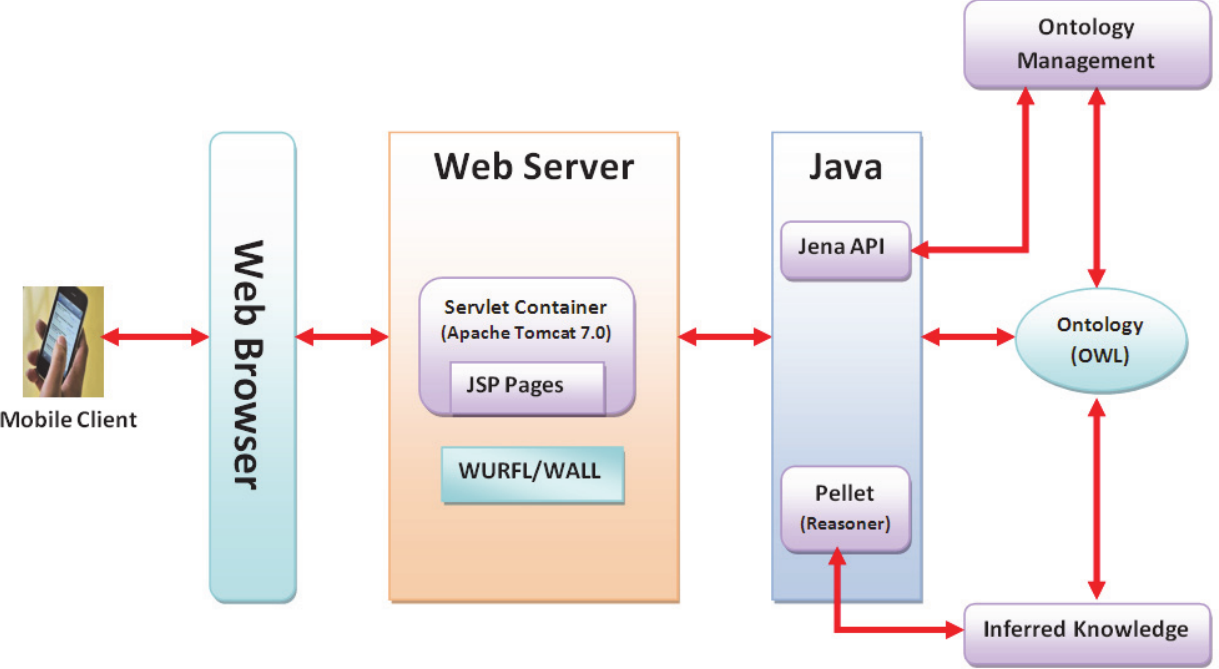
Figure 4 . Technical architecture of the ‘ThinknLearn’